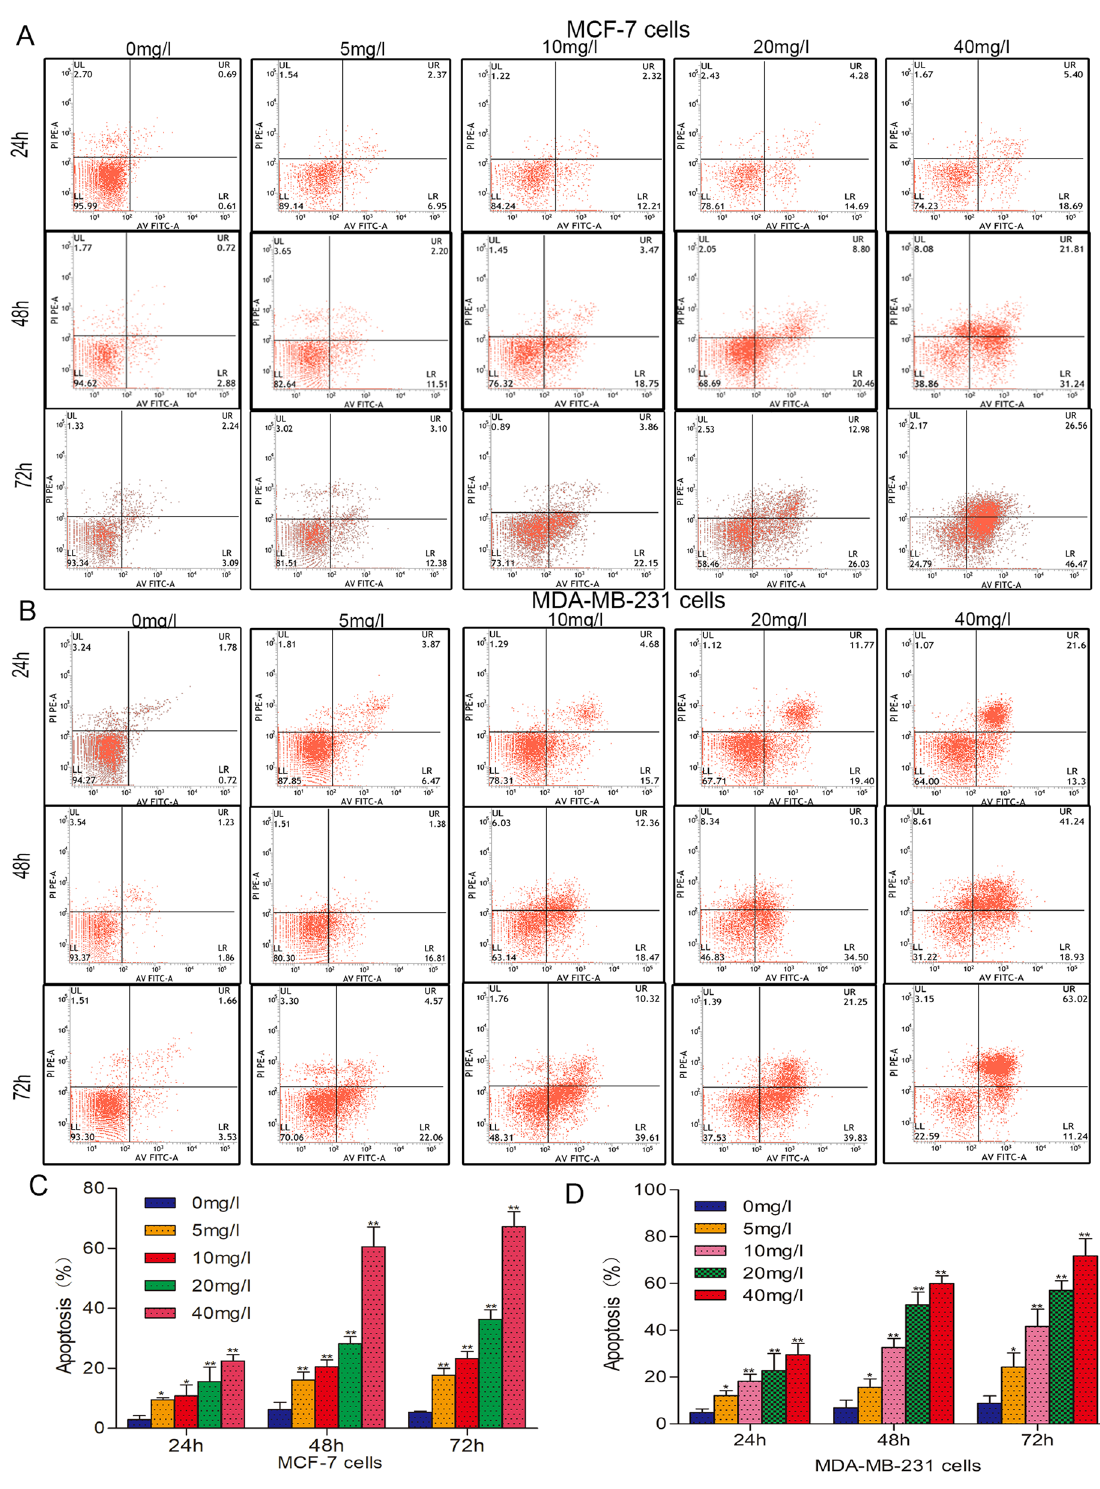
Figure 3. VALD-3 induces apoptosis in MCF-7 cells and MDA-MB-231cells. Apoptosis was analyzed via flow cytometry after Annexin V/PI staining. ( A ) Annexin V-FITC/PI double staining was used to detect the apoptotic rate of MCF-7 cells after VALD-3 treatment for 24 h, 48 h and 72 h. ( B ) Annexin V-FITC/PI double staining was used to detect the apoptotic rate of MDA-MB-231 cells after VALD-3 treatment for 24 h, 48 h, and 72 h. ( C ) Statistical analysis of the apoptotic rate of MCF-7 cell population after VALD-3 treatment for 24 h, 48 h and 72 h. ( D ) Statistical analysis of the apoptotic rate of MDA-MB-231 cell population after VALD-3 treatment for 24 h, 48 h and 72 h. * P < 0.05, ** P < 0.01 compared with the control group. All data are presented as the mean ± SD from three independent